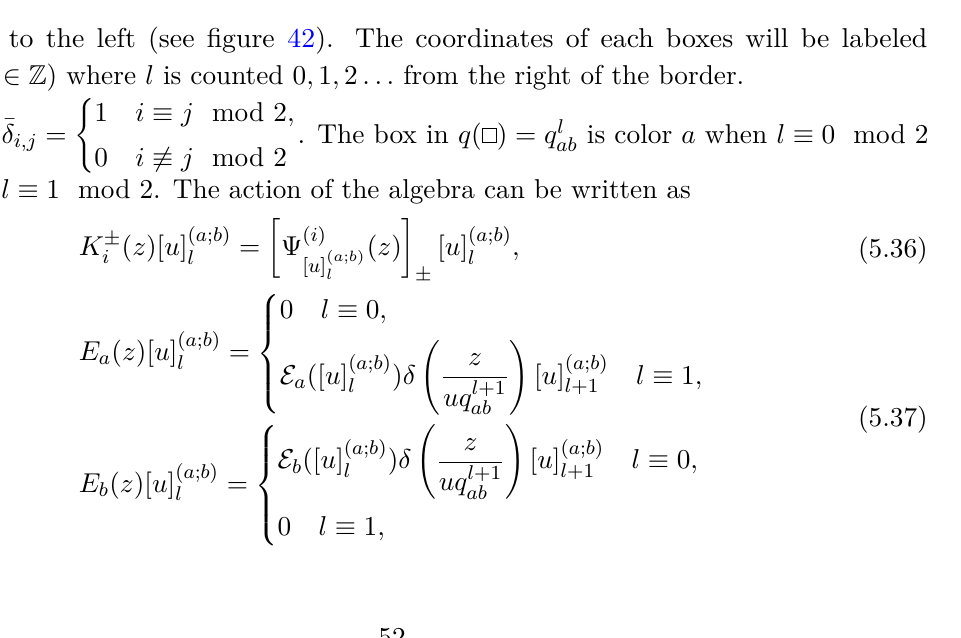
Figure 42. Basis of one-dimensional crystal